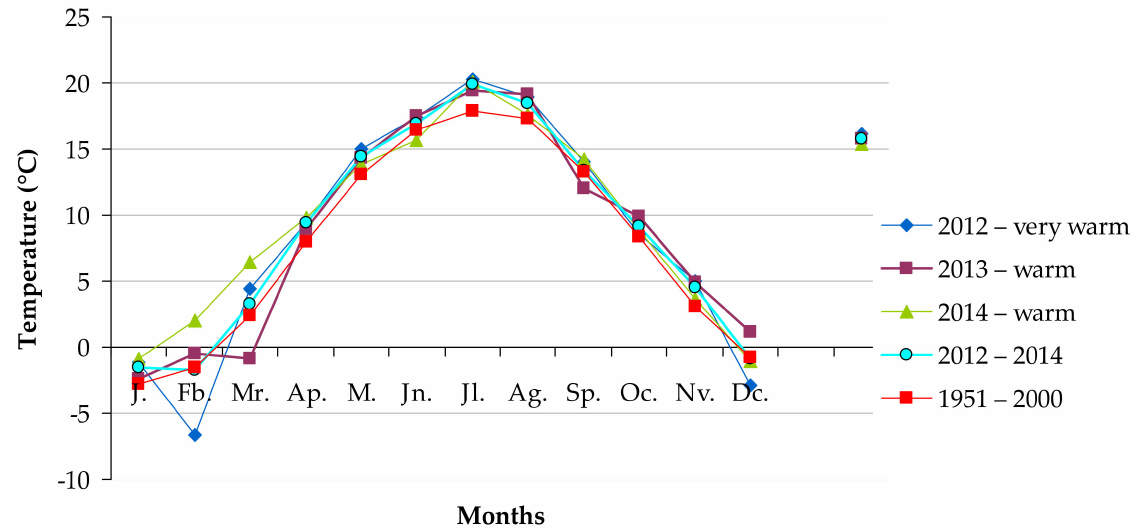
Figure 4. Mean temperatures ( ◦ C) during the study and in the 1951–2000 multiyear. Descriptors very warm and warm correspond to the 1951–2000